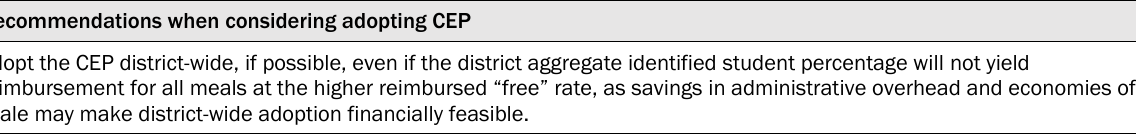
Table 3. Cafeteria Manager and Food Service Director ( n =28) Recommendations for Community Eligibility Provision (CEP) Implementation Best